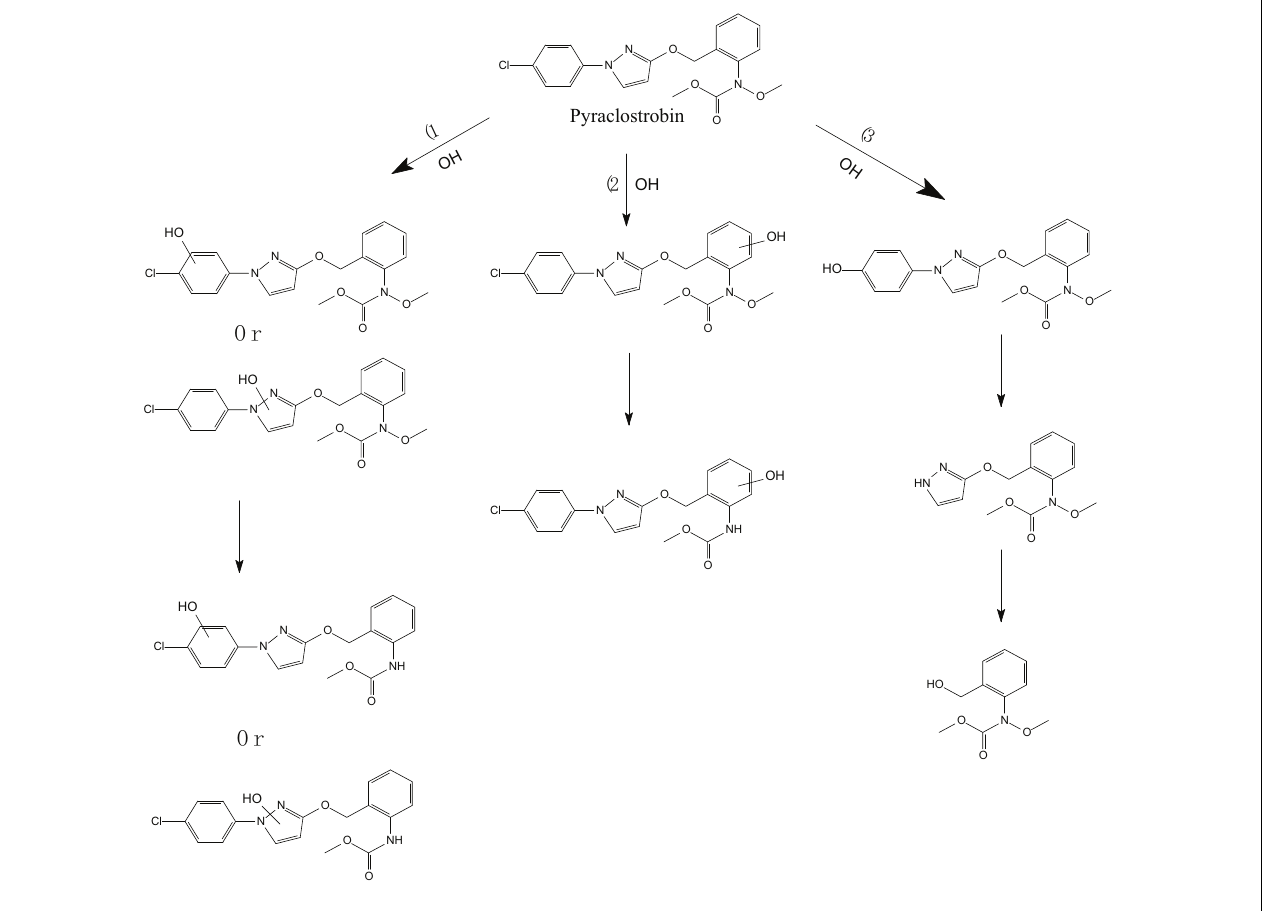
FIGURE 5 | Proposed degradation pathway of pyraclostrobin via the photocatalysis reaction (based on Lagunas-Allué et al., 2012).